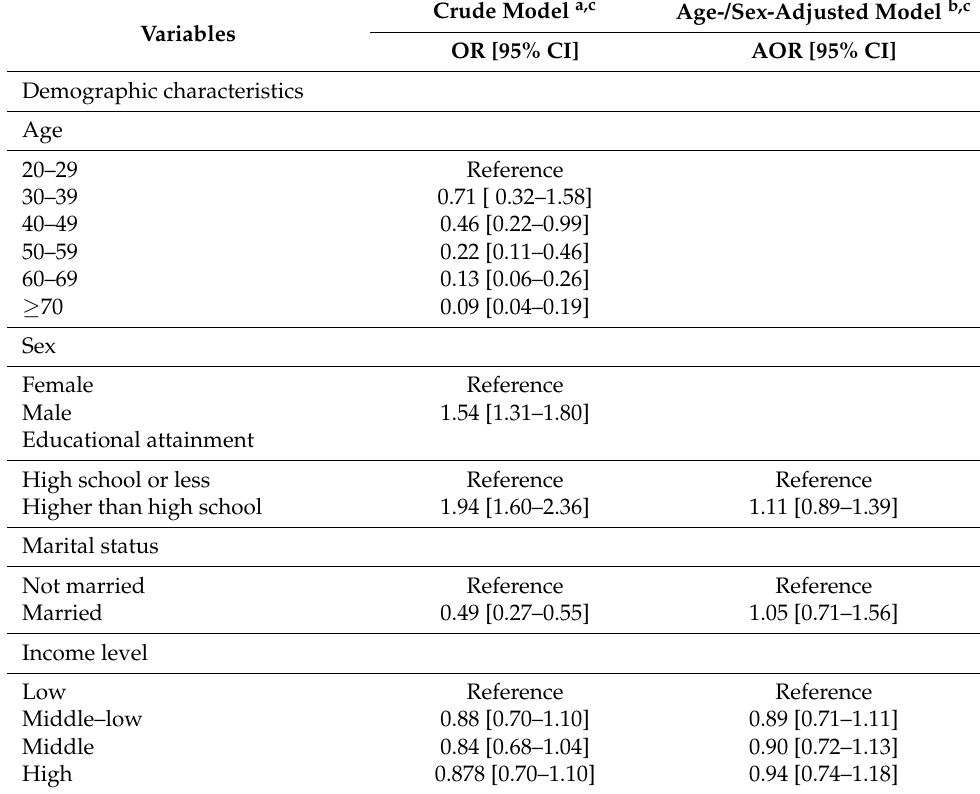
Table 3. Results of the analysis investigating the association between baseline risk factors and UDM status using logistic regression models. The DM group was used as the